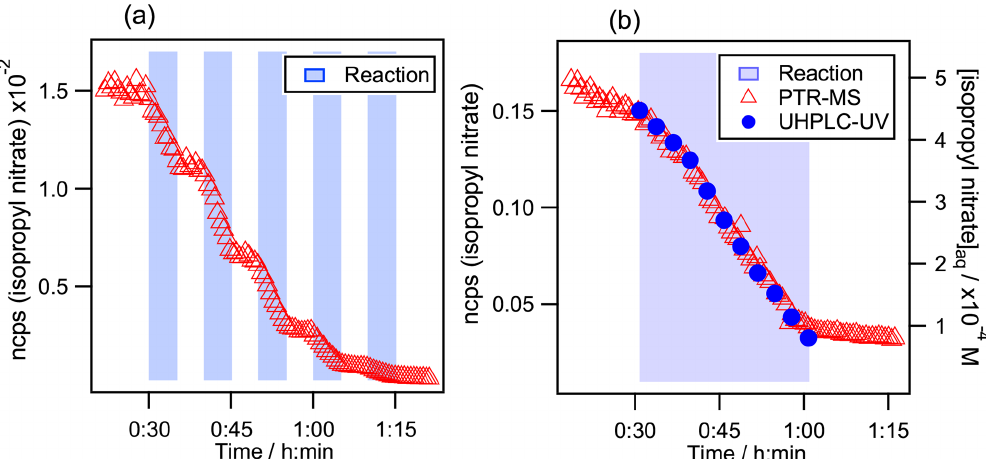
(cid:113) Figure 2. Kinetic decays of isopropyl nitrate during its aqueous-phase OH oxidation. (a) Monitored by PTR-MS during several sequential additions of the Fe 2 + solution. Initial conditions in the reactor were [Isopropyl nitrate] 0 = 5 × 10 − 5 molL − 1 , [H 2 O 2 ] 0 = 4 × 10 − 3 molL − 1 , and [H 2 SO 4 ] 0 = 5 × 10 − 3 molL − 1 . (b) Intercomparison between PTR-MS and UHPLC-UV detection. Initial conditions were [Isopropyl nitrate] 0 = 6 × 10 − 4 molL − 1 , [CH 3 OH] 0 = 3 × 10 − 4 molL − 1 , [H 2 O 2 ] 0 = 4 × 10 − 3 molL − 1 , and [H 2 SO 4 ] 0 = 5 × 10 − 3 molL − 1 . In both graphs, the time is set to 0 when isopropyl nitrate is injected. Blue background indicates periods when the solution of Fe 2 + (0.06molL − 1 ) (cid:113) was dripped into the reactor to produce OH radicals.